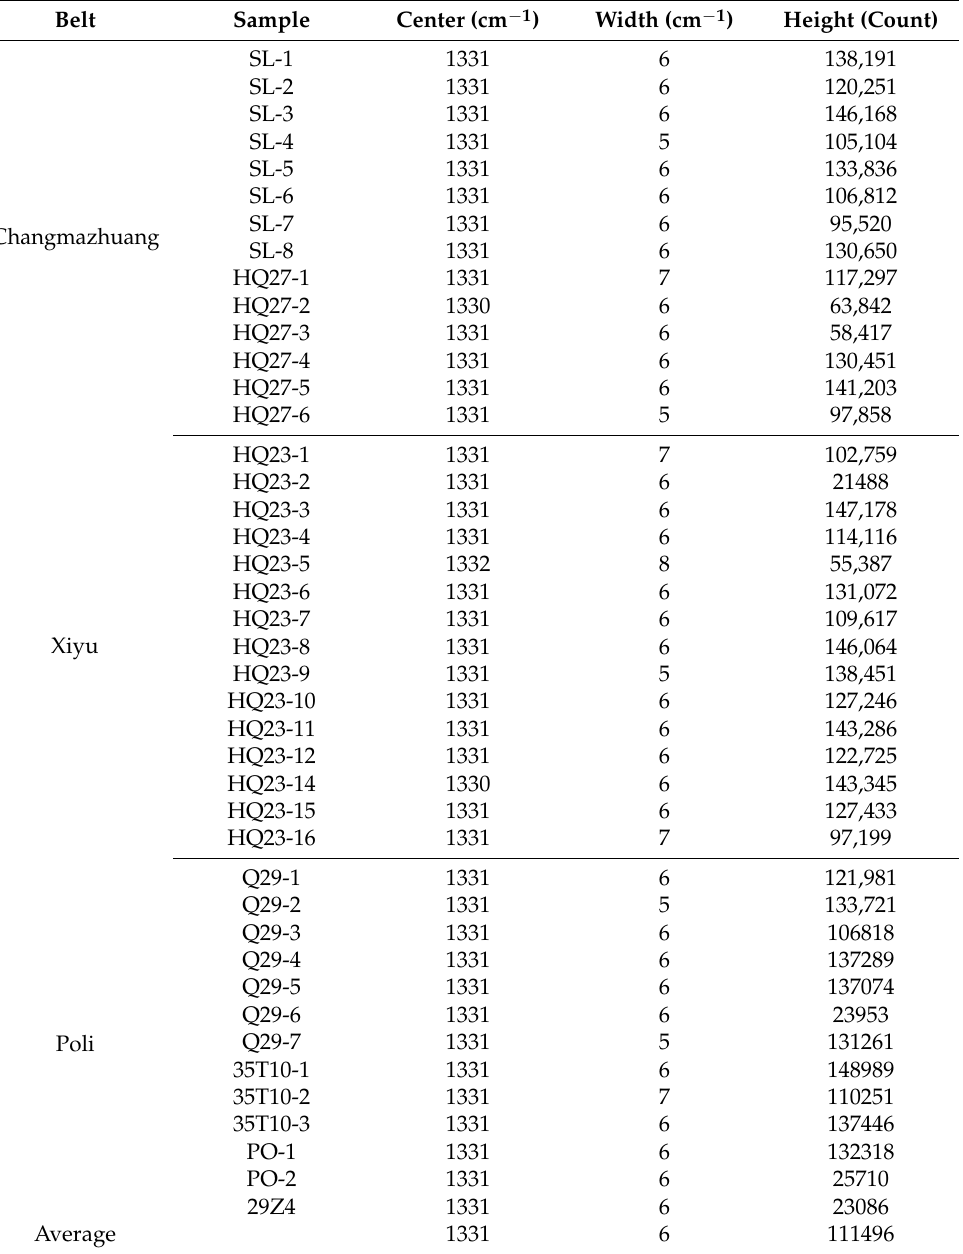
Table 3. Raman spectra of studied diamonds in the three